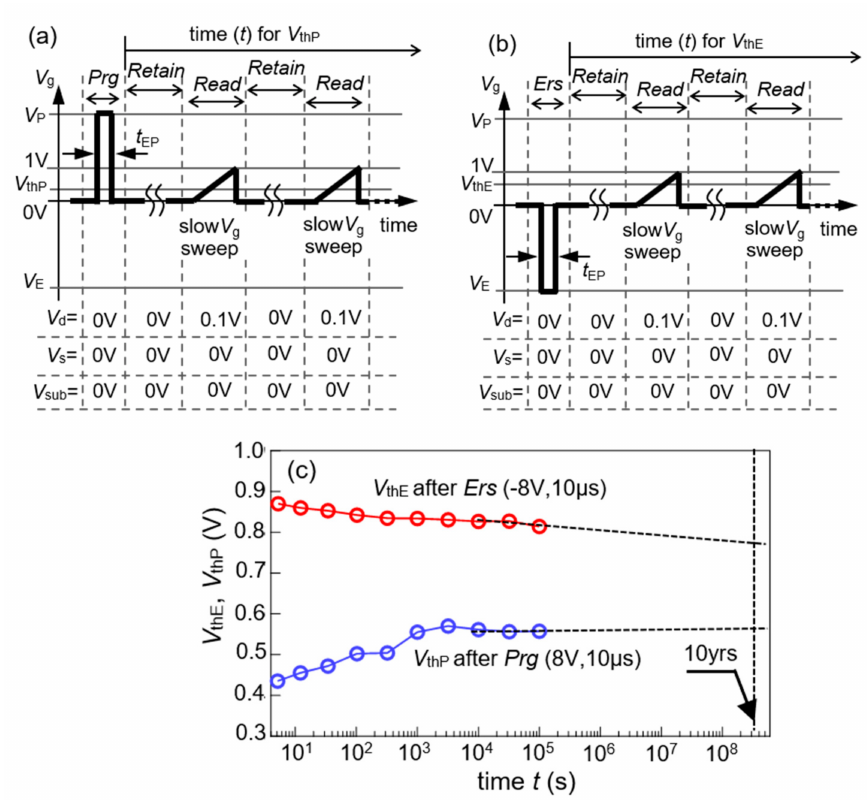
Figure 6. Retention investigation after applying V g pulses to a FeFET with L ch = 85 nm. The channel width was W = 100 µ m. The measurement procedures for the retentions of ( a ) V thP after Prg of ( V P , t EP ) and ( b ) V thE after Ers of ( V E , t EP ). ( c ) The measured retentions for 10 5 s each. Dashed lines are extrapolations of V thP – log( t ) and V thE -log( t ) for estimating V thP and V thE after ten